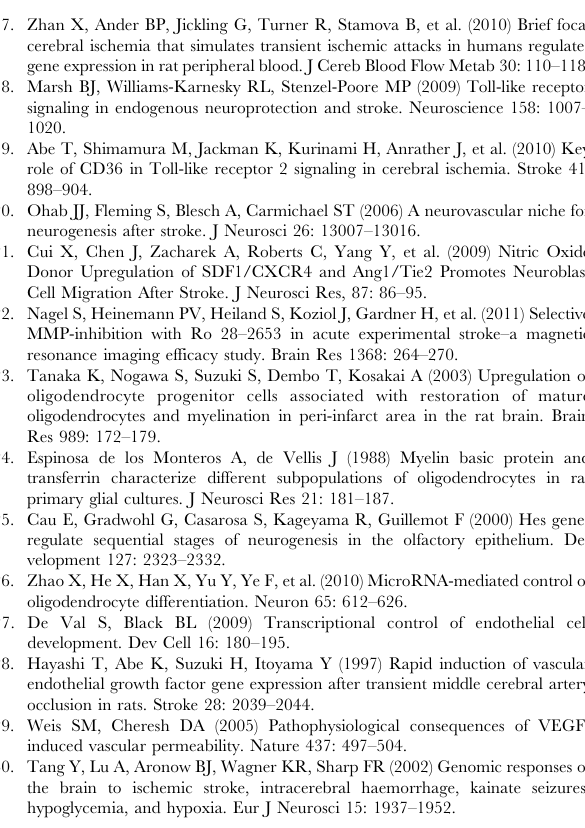
Table S2 Differentially expressed genes in the periin- farct at 24 h. Table S3 Differentially expressed genes in the core at 3 d. Table S4 Differentially expressed genes in the periin- farct at 3 d. Table S5 Differentially expressed genes in the core compared with periinfarct at 24 h. Table S6 Differentially expressed genes in the core compared with periinfarct at 3